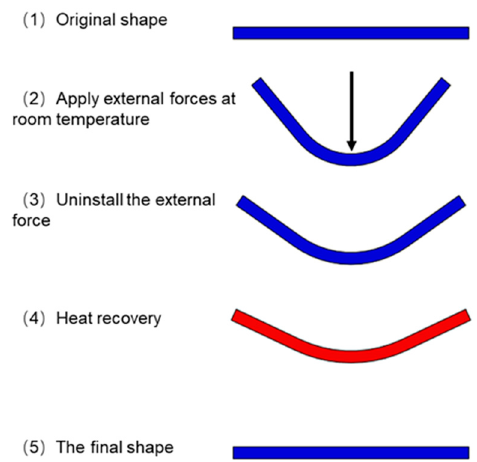
Figure 6. Schematic diagram of the forming process of metal embedded PLA weldment.